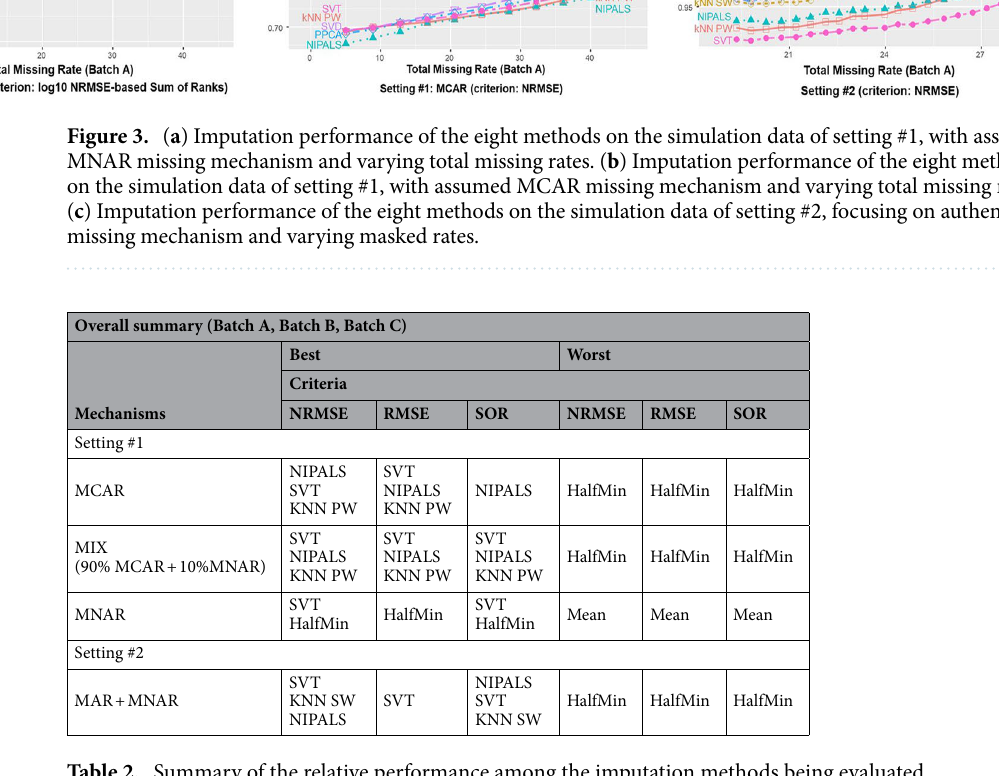
Table 2. Summary of the relative performance among the imputation methods being